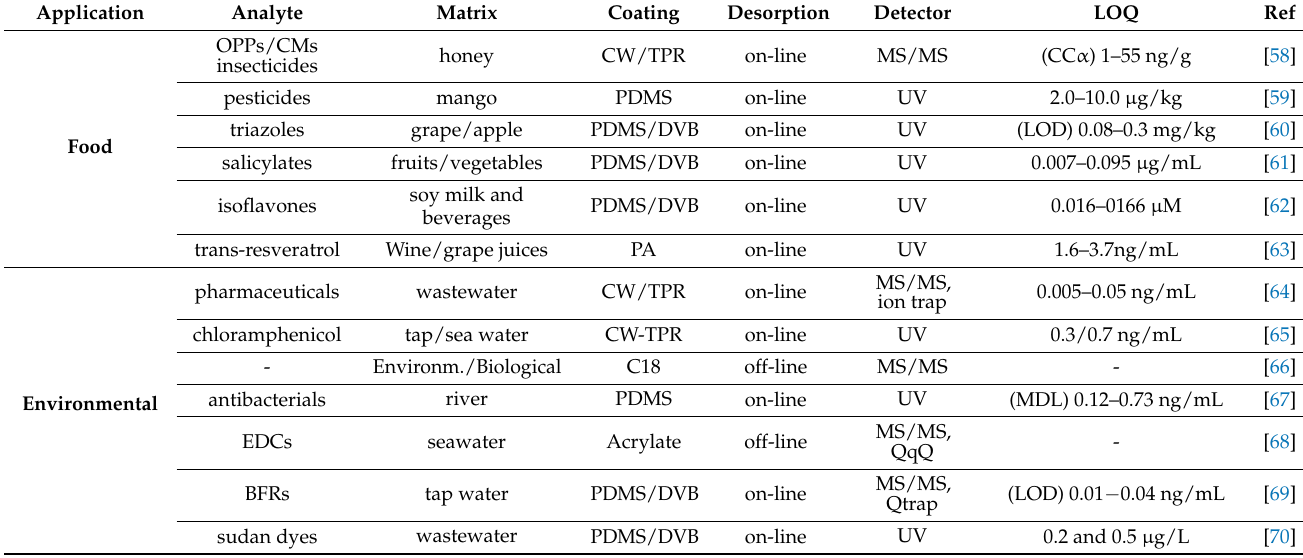
Table 2. Food and environmental applications of